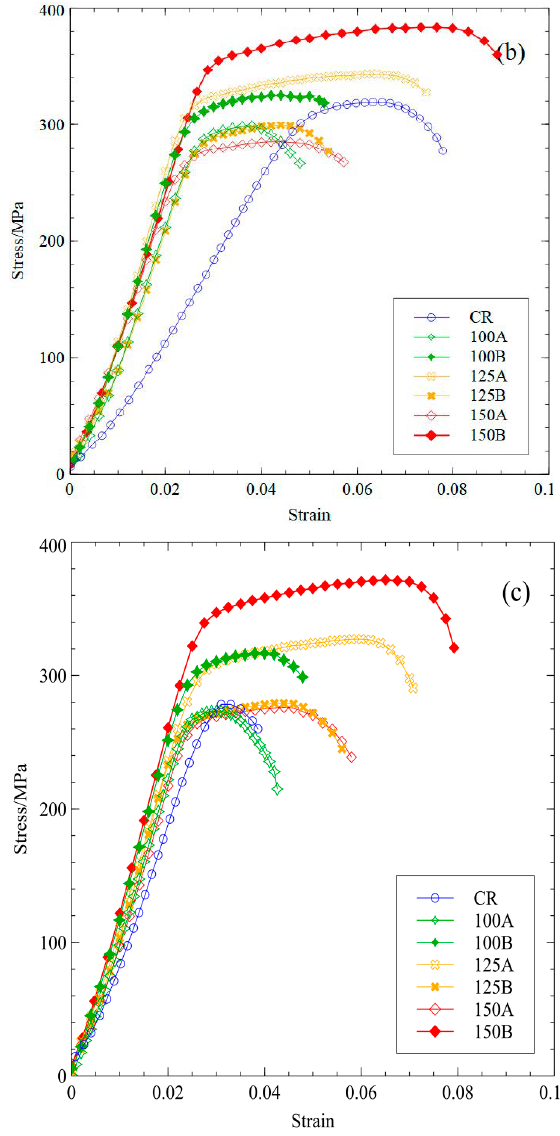
Figure 6. Stress-strain curve of samples ( a ) parallel to, ( b ) 45 ◦ to, and ( c ) perpendicular to the rolling direction.